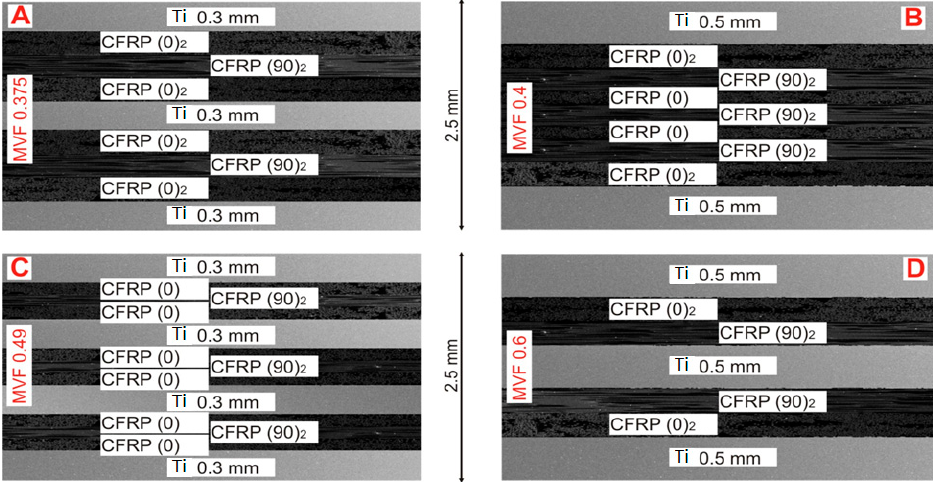
Figure 1. Mesoscale view of hybrid titanium–carbon composite laminates (HTCL) types ( A – D ) with constant total thickness and different metal volume fraction.